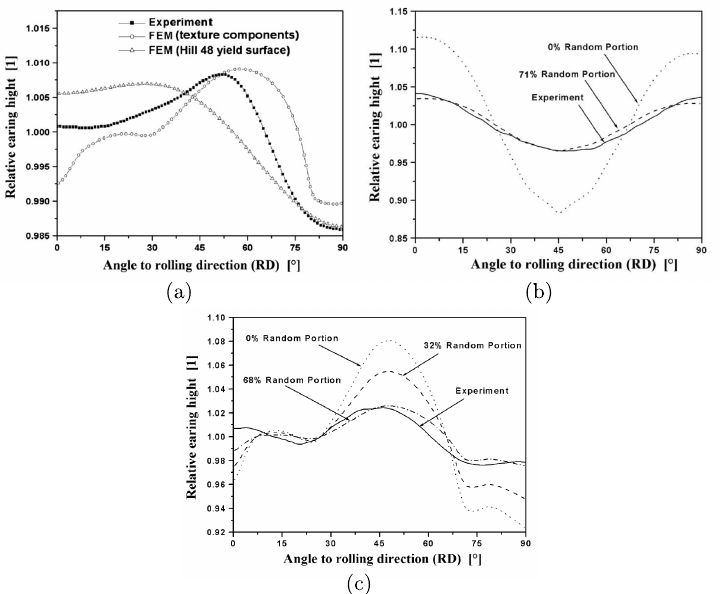
Figure 7. Experimental and simulation results of earing profile after cup drawing for aluminium sheet: ( a ) comparison of results between the texture component-based crystal model and Hill 48 yield surface model and experiment; ( b ) simulation and experimental results in which the texture is approximated using the volume fraction; ( c ) simulation and experimental results in which the texture is approximated using two rolling texture components and a random texture component. Reproduced from [174], under permission.